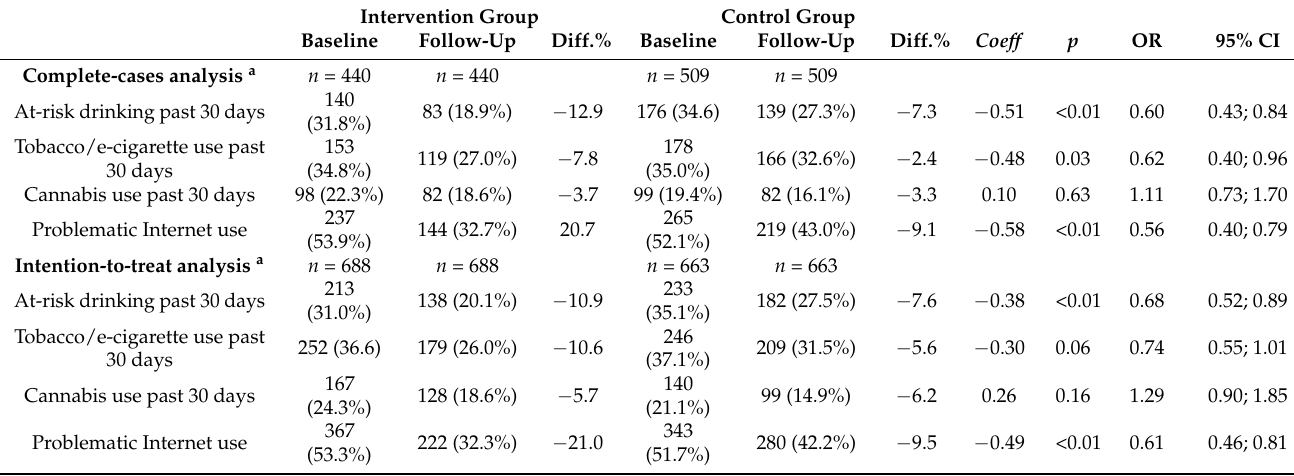
Table 2. Intervention effects for dichotomous outcomes. Values represent n (% within sub-sample), unless stated otherwise.